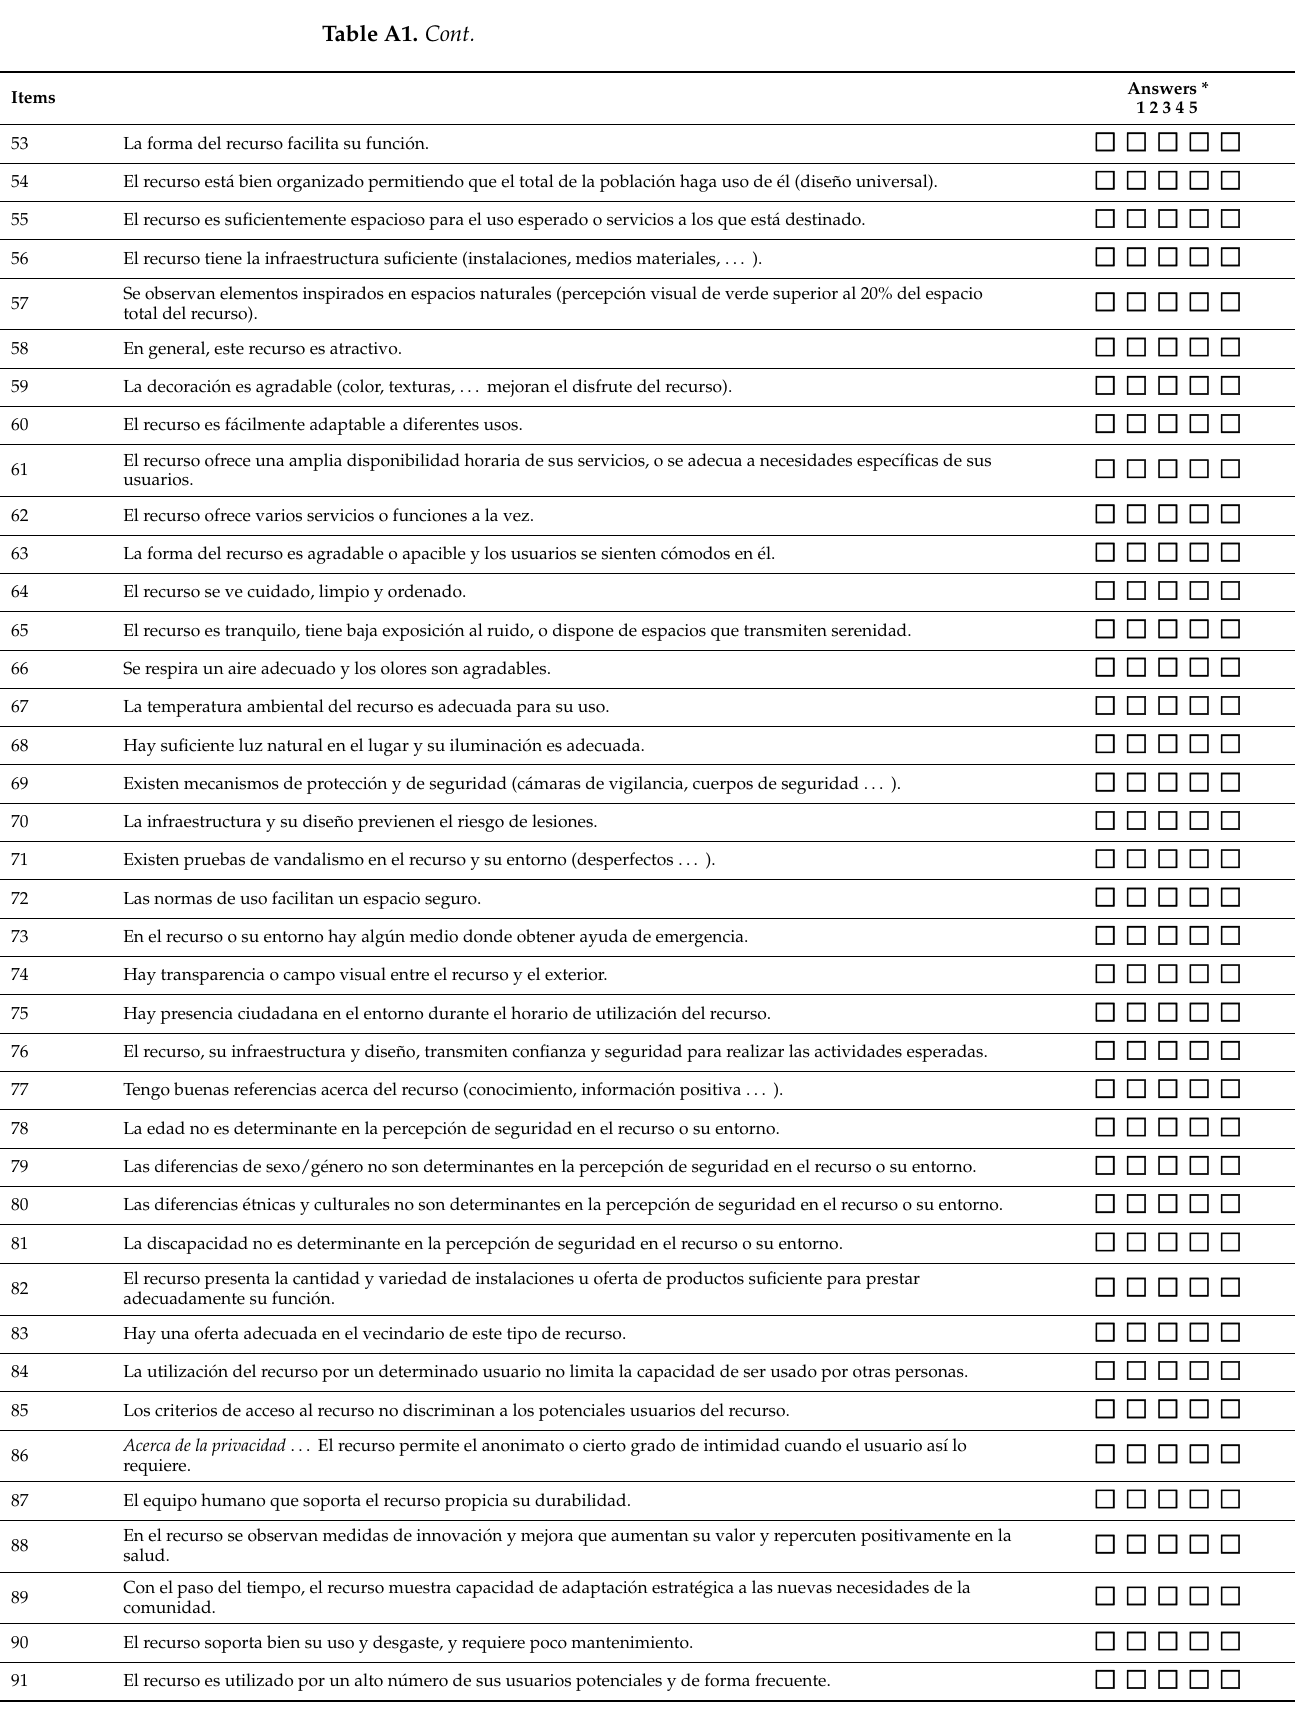
Table A1. Community assets for health assessment scale.